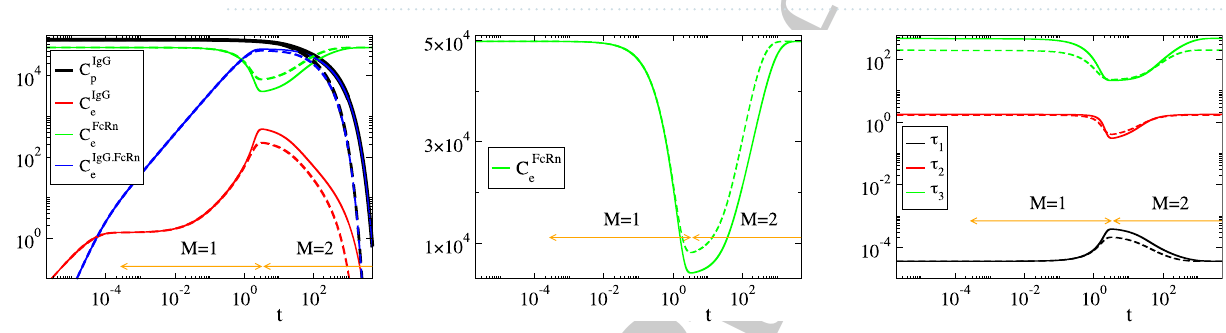
Figure 9. The reference (solid, k off ) and the perturbed (dashed, 2.0 k off ) concentration and time scale profiles. The indicated M = 1 and M = 2 periods refer to the reference case.